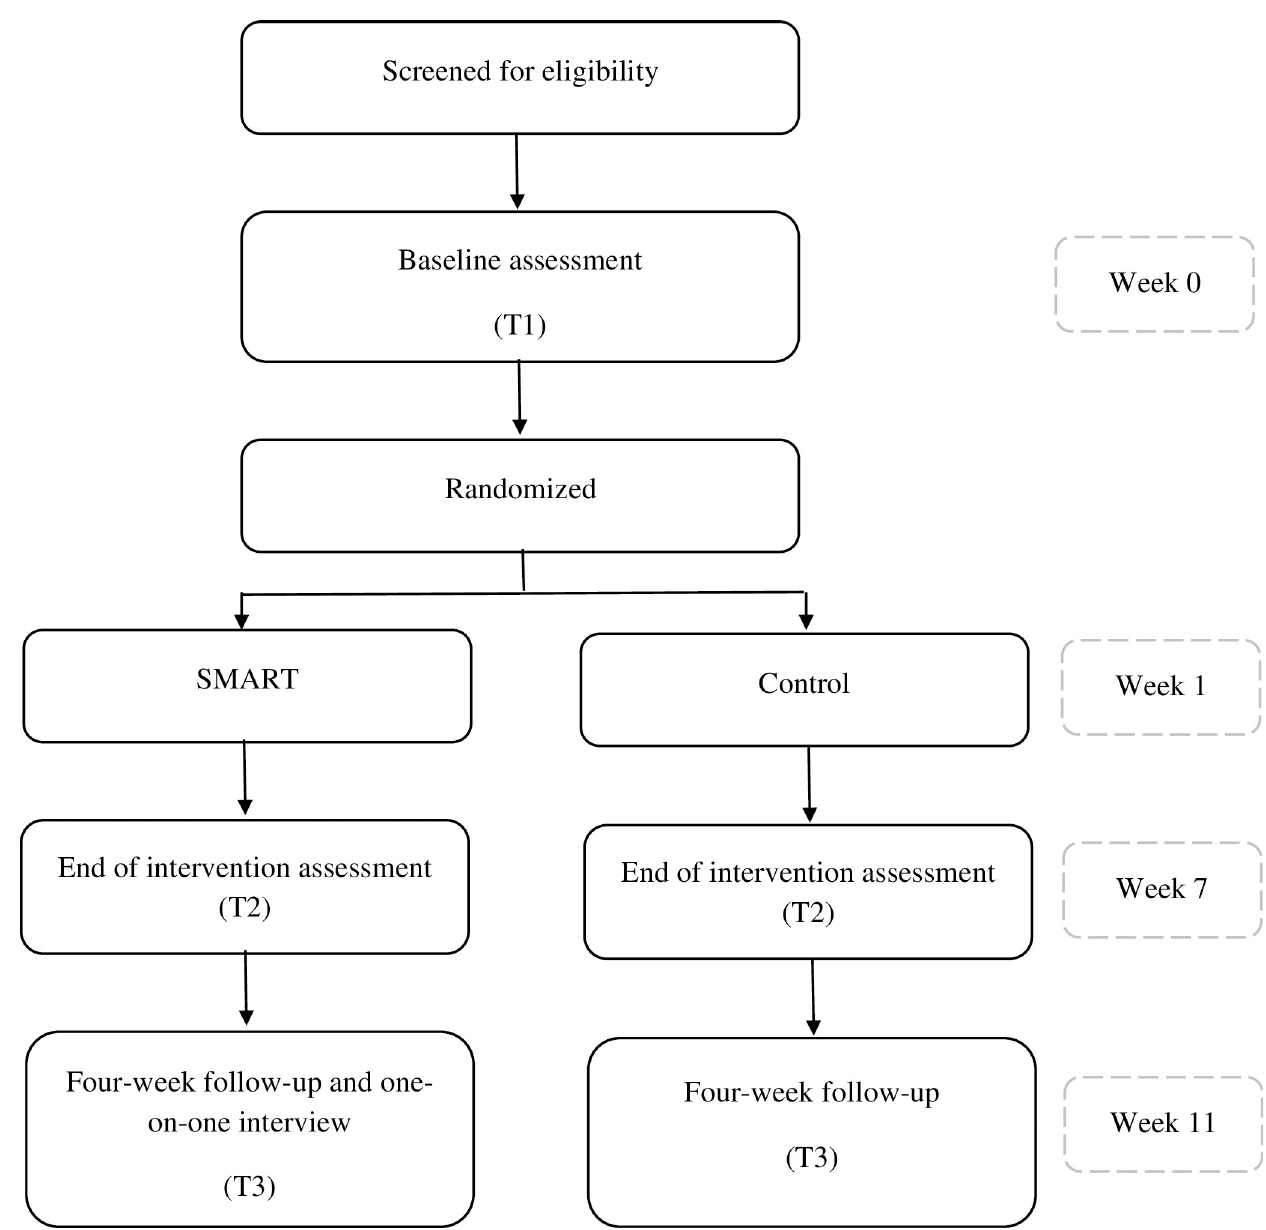
Fig 2. Flow diagram of study progress in terms of participants enrolment, group allocation, follow-up, and data analysis [78]. ratio 1:1 group allocation. In our prior feasibility study, the minimal detectable difference of improvement in TUG after six weeks of using SMART was 2.1 seconds in adults with unilat- eral LLL (median age = 56 y) [22]. We interpreted this change as meaningful because the find- ings of the qualitative component of the same study revealed that participants perceived SMART and peer support could improve their mobility confidence and encourage them to take actions towards their goals, which was more walking. Assuming a minimum detectable difference of 2.1 seconds, 80% power, and type-I error probability of 0.05, we need to enroll a minimum of 38 participants per group. In our feasibility study, the retention rate was 100%